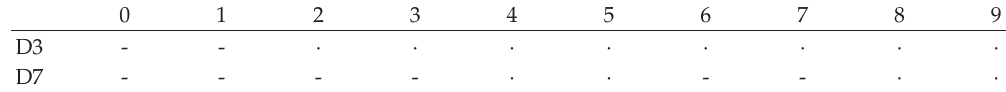
Table 1: Embedding of the flavor